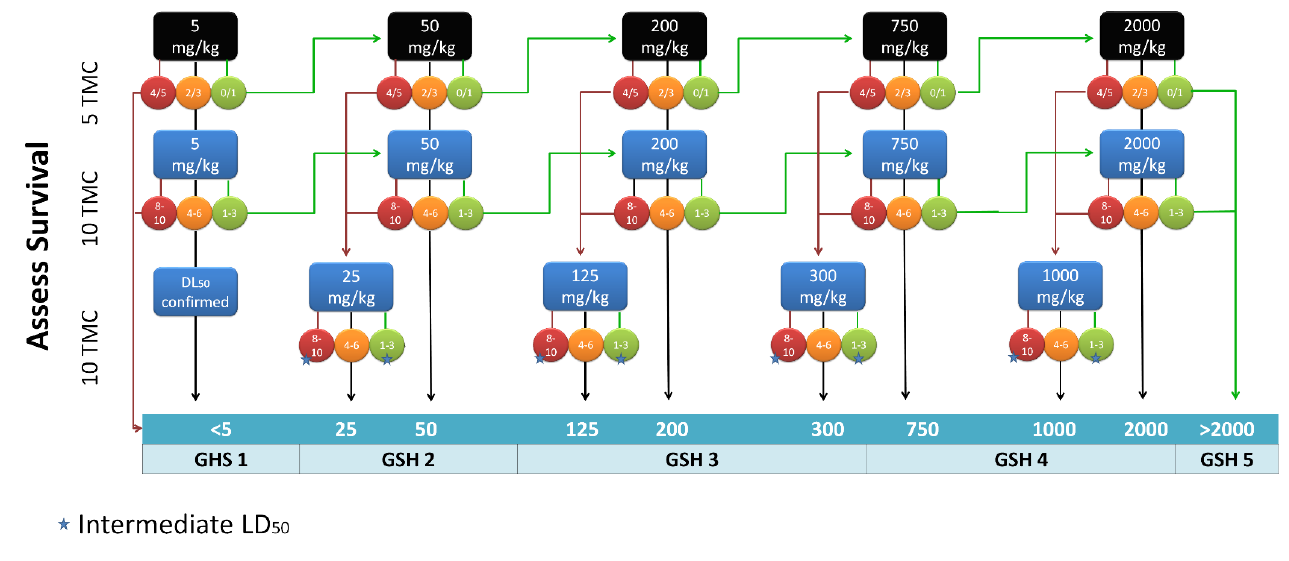
Figure 2. Flowchart for LD50 determination. Starting from the opportune initial dose, LD50 was determined by changing the dose based on results and increasing the number of TML for final determinations. GHS cat.: Globally Harmonized System category. The numbers on the circles represent the number of deaths in exemplars. The star indicates that if the mortality was not 50%, the experiment was repeated using an intermediate dose. Table 2. Drugs analyzed for toxicity studies in adult exemplars of T. molitor Coleoptera, LD50 literature data for mice and rats, and experimental data